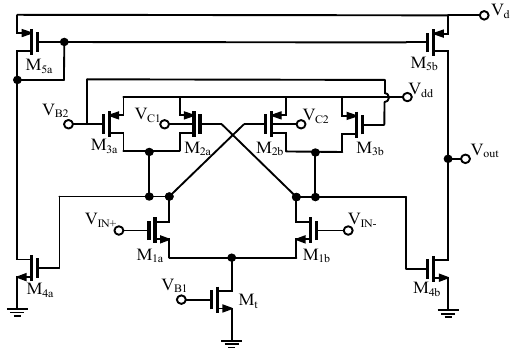
Figure 5. The proposed Schmitt trigger with adjustable hysteresis.